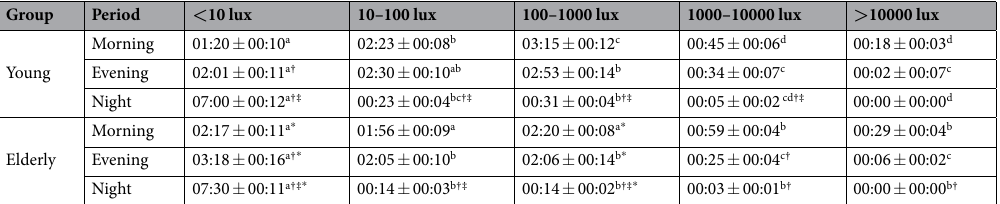
Table 2. Time of exposure to different light intensities by day period and age group (elderly participants, n = 44; young participants, n = 44). Time spent at different light intensities during three time intervals during daytime (morning from 08:00 to 15:50, evening from 16:00 to 23:50 and night from 00:00 to 07:50) for young and elderly participants. All the data are expressed as mean ± SEM (hh:mm). * Indicates statistically significant differences with the young group in the same light intensity and period, † Indicates statistically significant differences with morning in the same light intensity and age group, ‡ Indicates statistically significant differences with evening in the same light intensity and age group and different letters indicates statistically significant differences among light intensities in the same time window and age group according to General Linear Model repeated measures controlling for gender with post-hoc Benjamini-Hochberg procedure for multiple